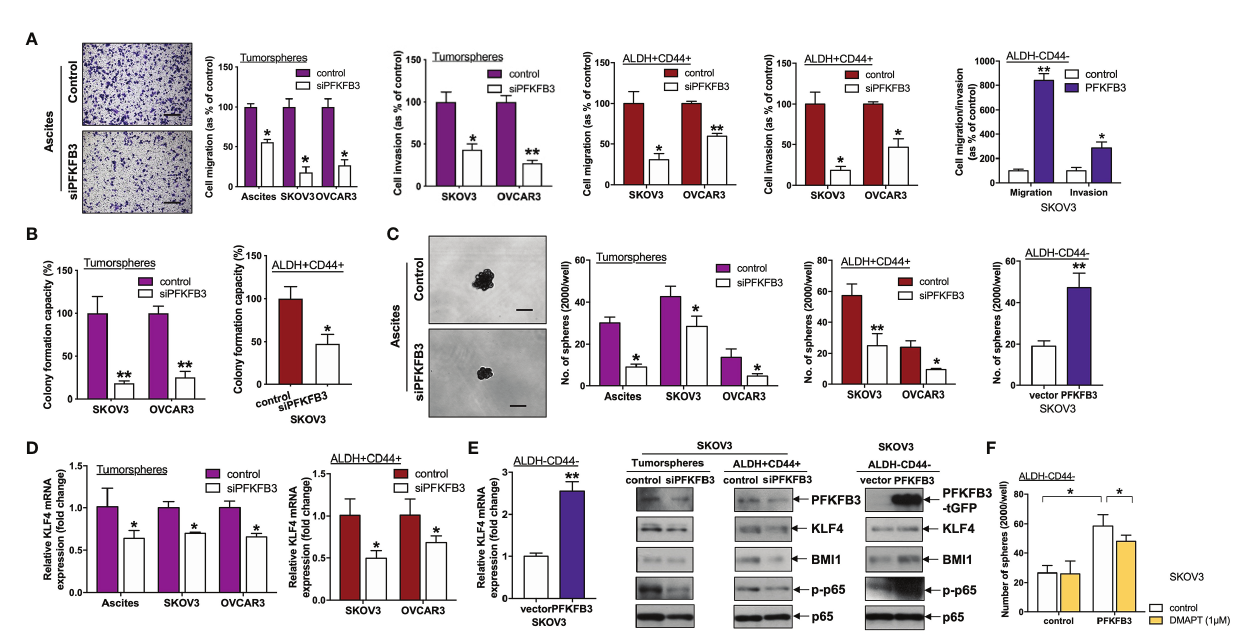
FIGURE 4 | PFKFB3 promotes stemness in ovarian cancer. (A) Transwell migration/invasion assays of PFKFB3-suppressing tumorspheres and ALDH+CD44+ cells and PFKFB3-overexpressing ALDH-CD44- cells. Representative images of migrating tumorspheres with transient knockdown of PFKFB3 (left; scale bar, 100 m m). (B) Clonogenic assay of tumorspheres and ALDH+CD44+ cells transfected with control and siPFKFB3 duplexes cells. (C) Sphere formation assay of PFKFB3- suppressing tumorspheres and ALDH+CD44+ cells and PFKFB3-overexpressing ALDH-CD44- cells. Representative images of sphere-forming cells with transient knockdown of PFKFB3 (left; scale bar, 100 m m). (D) Relative KLF4 mRNA expression of PFKFB3-suppressing tumorspheres and ALDH+CD44+ cells and PFKFB3- overexpressing ALDH-CD44- cells, determined by qPCR. (E) Protein expression of PFKFB3, KLF4, BMI1, p-p65 and p65 in PFKFB3-knockdown tumorspheres (left) ALDH+CD44+ (middle) SKOV3 cells and PFKFB3-overexpressing ALDH-CD44- (right) SKOV3 cells, determined by immunoblotting. (F) After DMAPT (1 m M) treatment of PFKFB3-overexpressing ALDH-CD44- cells for 48 h, sphere formation assays were conducted and analyzed. (n = 3; *p < 0.05, **p <